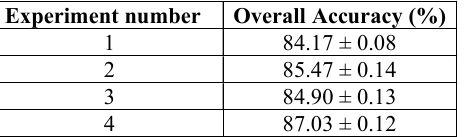
Recall values on Figure 3.